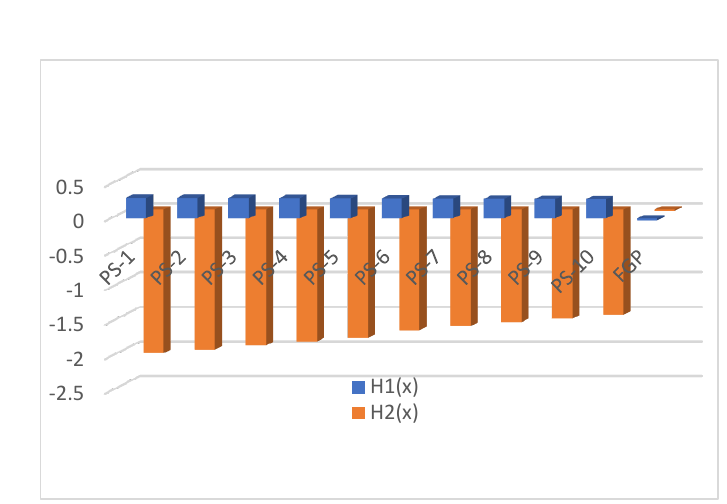
Figure 2. Comparison of objectives of first level with FGP.